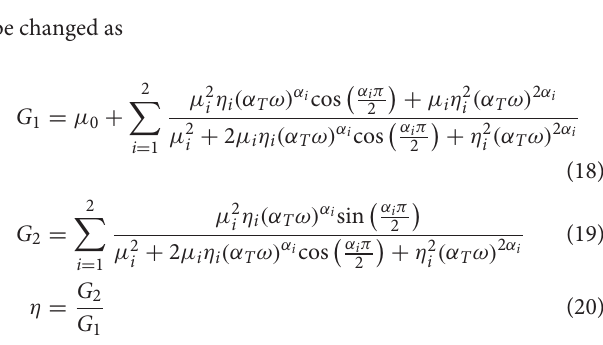
FIGURE 6 | The seven-parameter fractional derivative